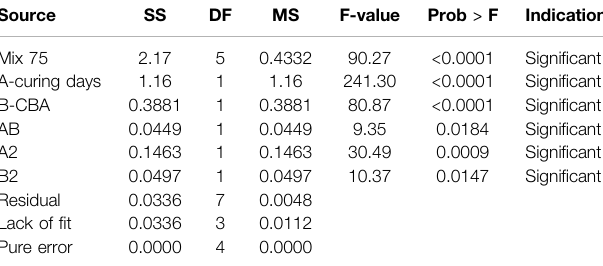
TABLE 8 | ANOVA for the response surface quadratic model.